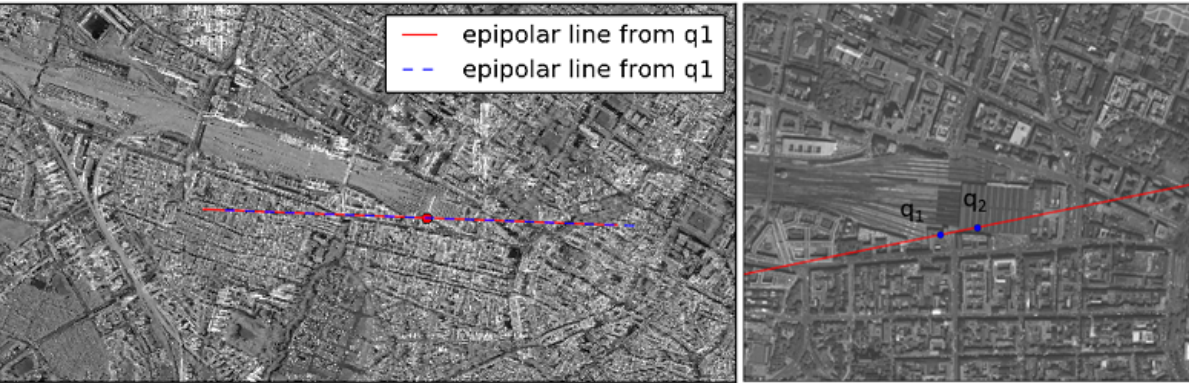
Figure 5. Corresponding Epipolar lines on the TerraSAR-X image (in the left) derived from two points; q1 and q2 on the epipolar line of the WorldView-2 image (in the right)